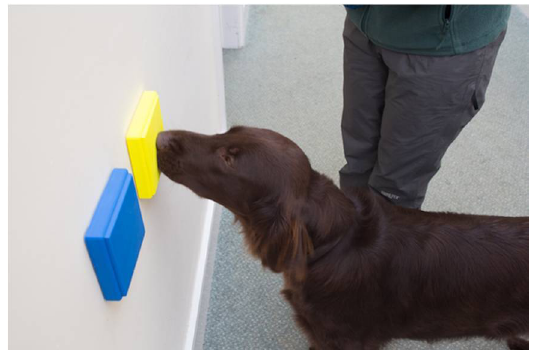
Figure 4. A dog activating a switch [21]. Photo courtesy of The Open University.